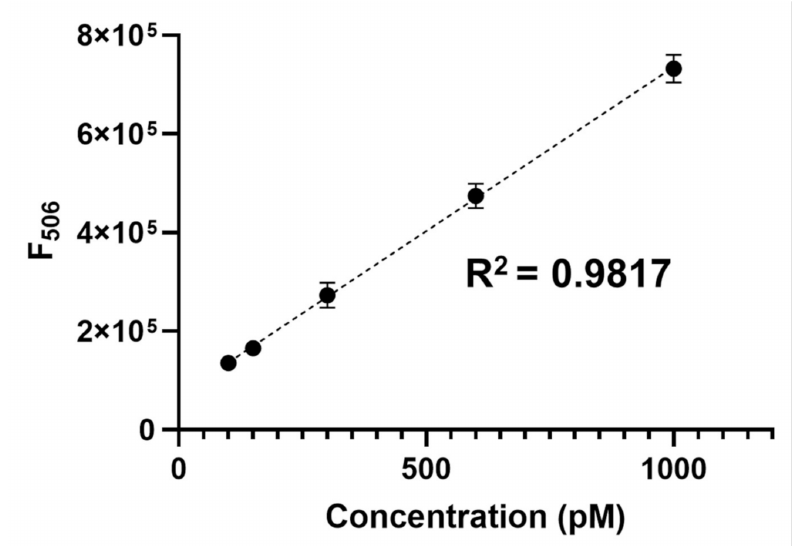
Figure 6. Linear relationship between the fluorescence intensity (F 506 ) and concentration of target nucleic acids spiked in the diluted human serum (1%). All experiments were performed in